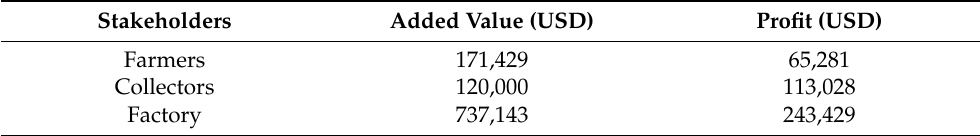
Table 2. Added value and profit of different stakeholders in business-as-usual